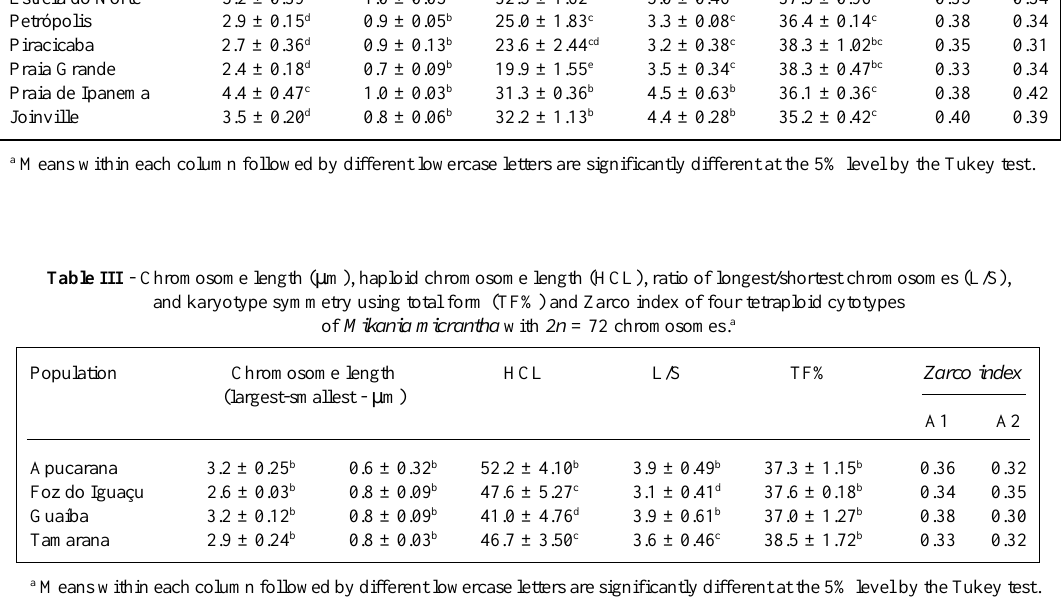
a Means within each column followed by different lowercase letters are significantly different at the 5% level by the Tukey test.